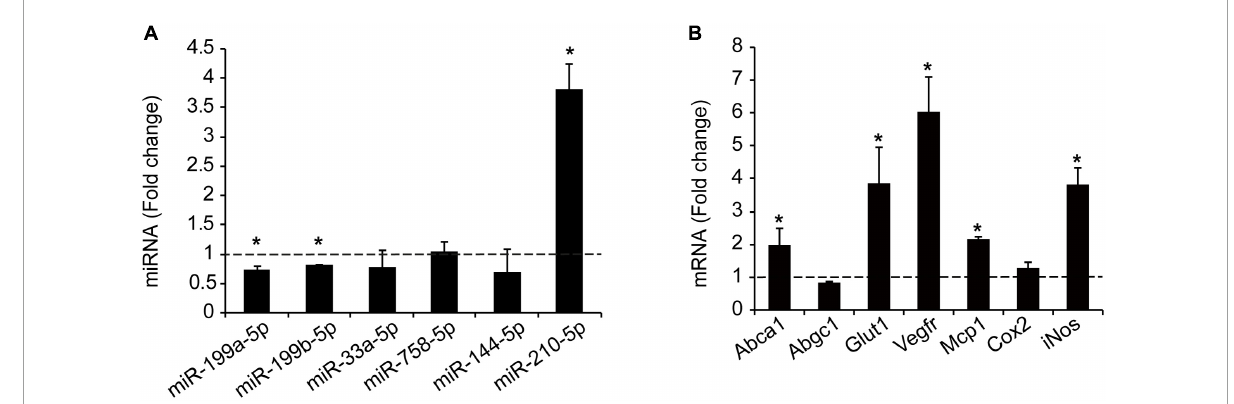
FIGURE2 Hypoxia regulates miRNAs and cholesterol transporter ABCA1. (A) qRT-PCR analysis of miR-199a-5pa, miR-199b-5p, miR-33a-5p, miR-758-5p, and miR-144-5p in peritoneal macrophages exposed to hypoxic conditions. HypoxamiR miR-210-5p was used as a positive control. (B) qRT-PCR analysis of Abca1, Abcg1, Glut-1, Vegfr, Mcp1, Cox-2, and iNos expression in mouse peritoneal macrophages during hypoxia conditions. Data are expressed as relative expression levels and correspond to the means ± SEM from three independent experiments performed in triplicate. *P < 0.05, significantly different from control normoxic cells.